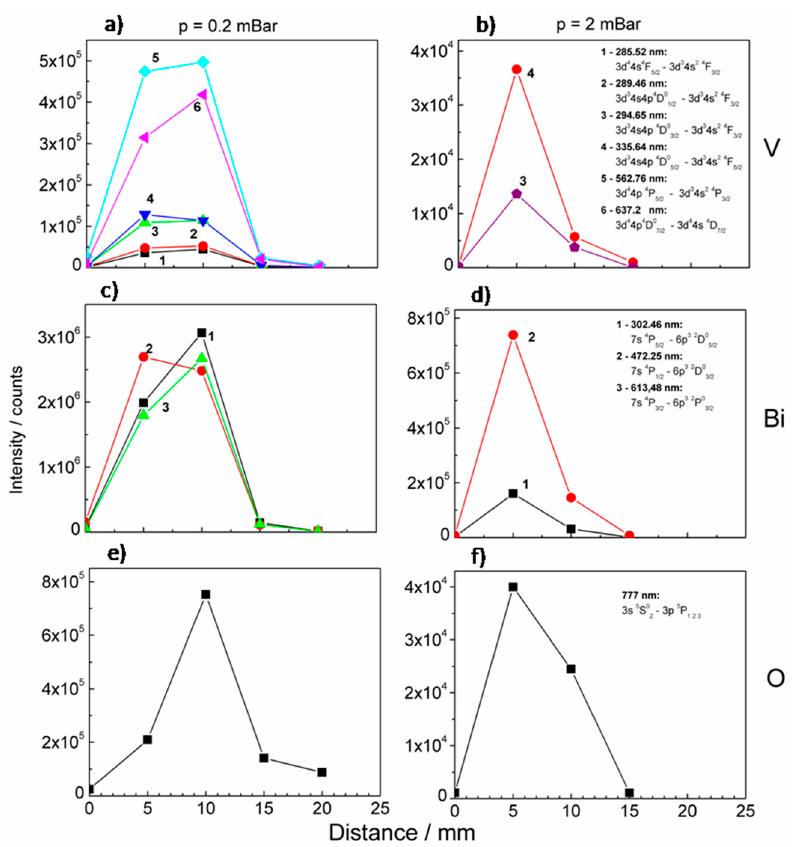
Figure 8. Line intensities as a function of distance from target for transitions in vanadium ( a,b ) 1—